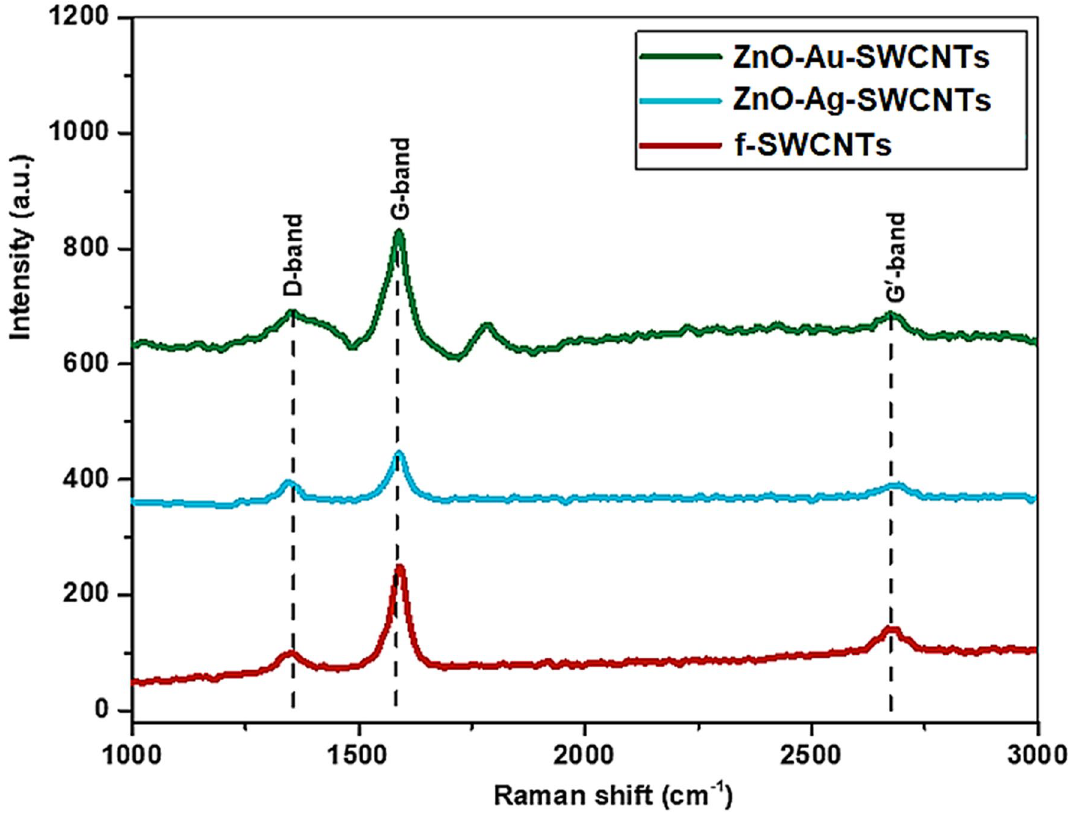
Figure 2. Raman spectra of ZnO–Au-SWCNTs, ZnO–Ag-SWCNTs, and f